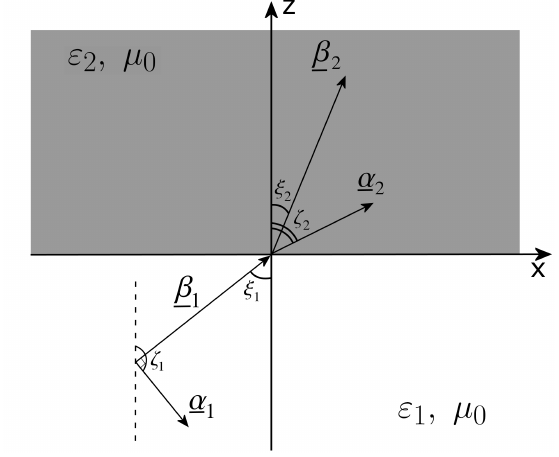
Figure 1. Geometry of the